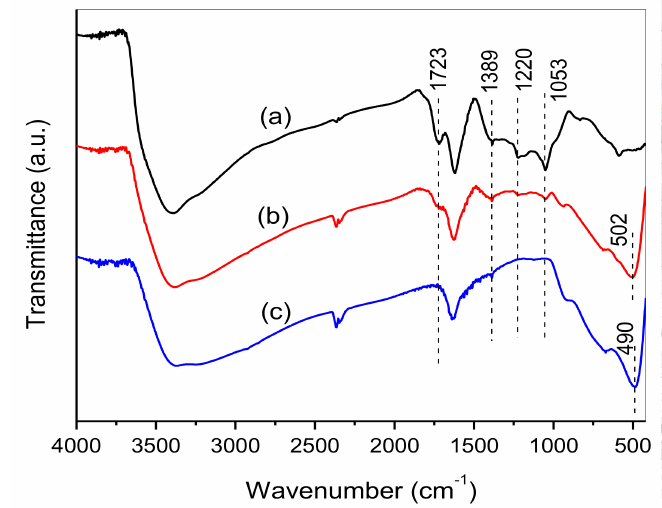
Figure 2. FTIR spectra of samples (a) GO, (b) HTT/graphene-1.0%, and (c) pure HTT.